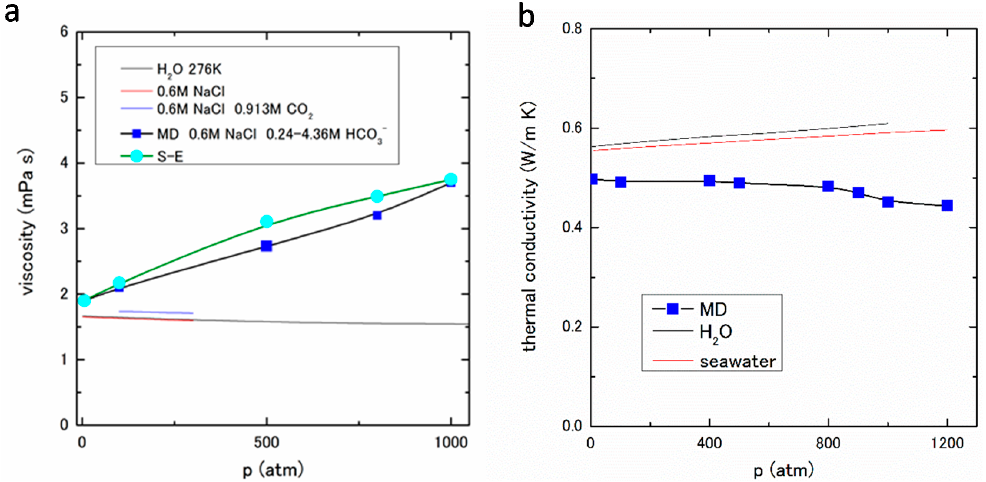
Figure 10. ( a ) Viscosity under pressures of 5–1000 atm; and ( b ) Thermal conductivity under pressures of 5–1200 atm.